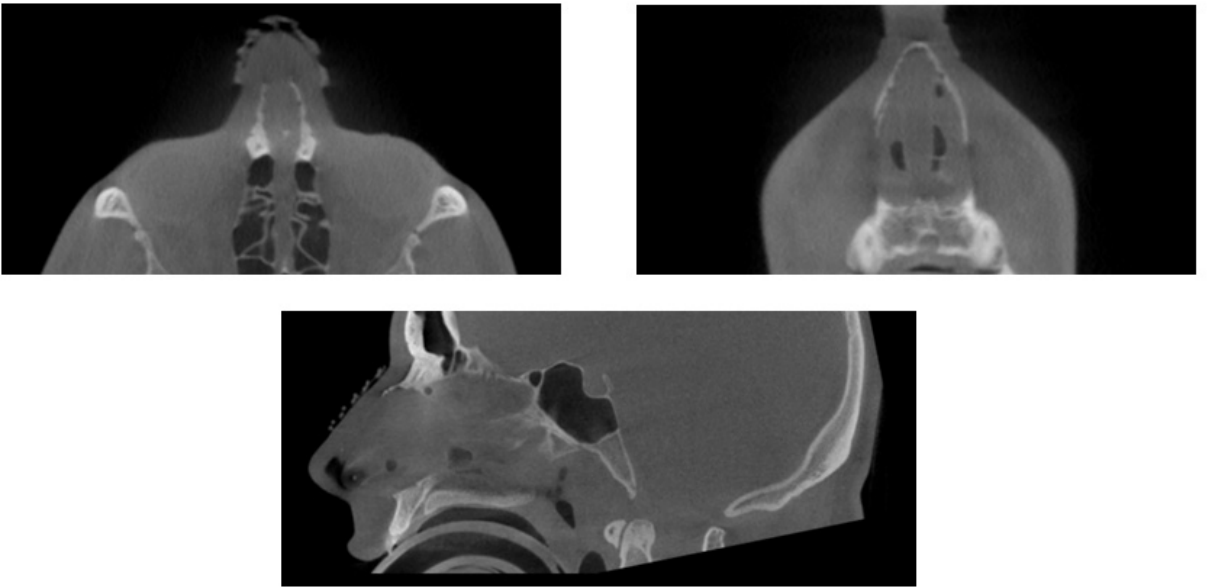
Figure 1. Multiplanar image reconstruction in natural head position (NHP) of an intraoperative CBCT picture showing a satisfactory